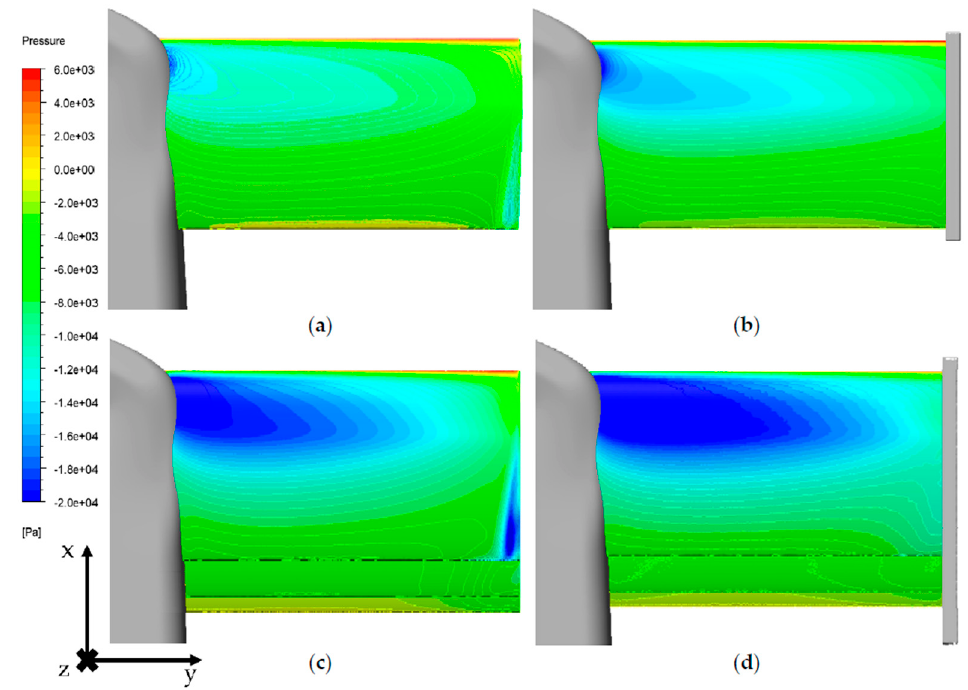
Figure 6. Distribution of pressure in the lower surface of ( a ) one-element without endplates; ( b ) one-element with endplates; ( c ) three-element without endplates; ( d ) three-element with endplates.